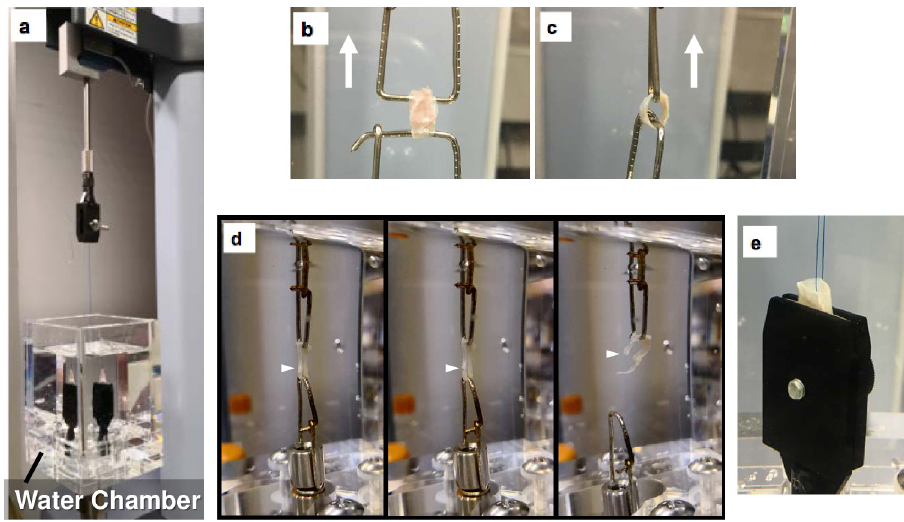
Fig 2. The entire appearance of the system including the specially designed water chamber for vessel ringlet pull test and suture retention stress test (a). A vessel ringlet sample was held by two parallel hooks (b: front view, c: side view). A broken sample by vessel ringlet pull test (d). White triangles indicate failure points. A sample for suture retention testing held in saline by the test piece grasping device. A 5–0 prolene suture was placed at the top end of the tissue tube